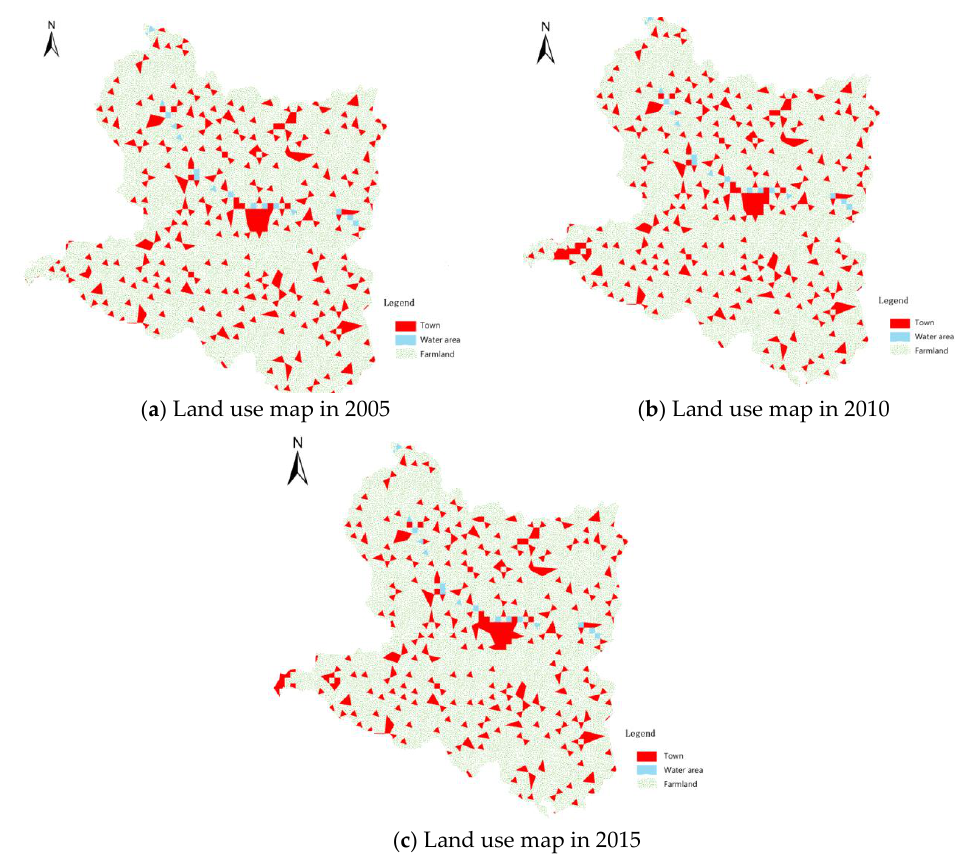
Figure 7. Land use maps of Dengzhou city in 2005, 2010, and 2015.